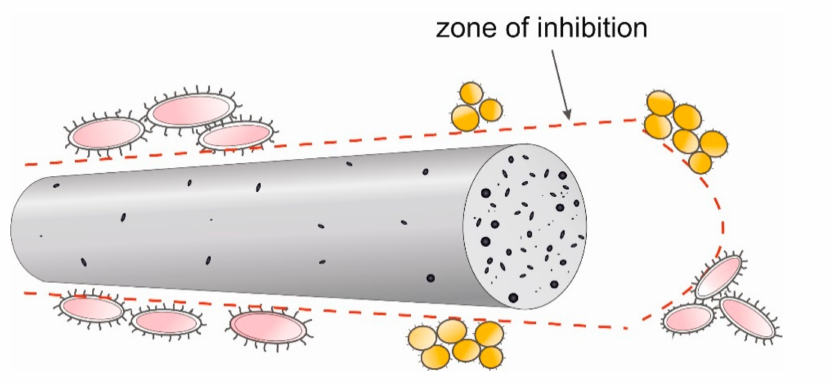
Figure 8. Model of pathogen cell destruction on the surface and at the cross-section of the fibre. S. aureus bacteria, on the other hand, are spherical in shape, with dimensions of 1 × 0.8 µ m and a thick cell wall. All these factors make the pathogen difficult to be destroyed by GO nanoparticles, both on the surface and in the cross-sections of GO/CEL fibres (Figure 8). This results in smaller inhibition zones that are observed in Figure